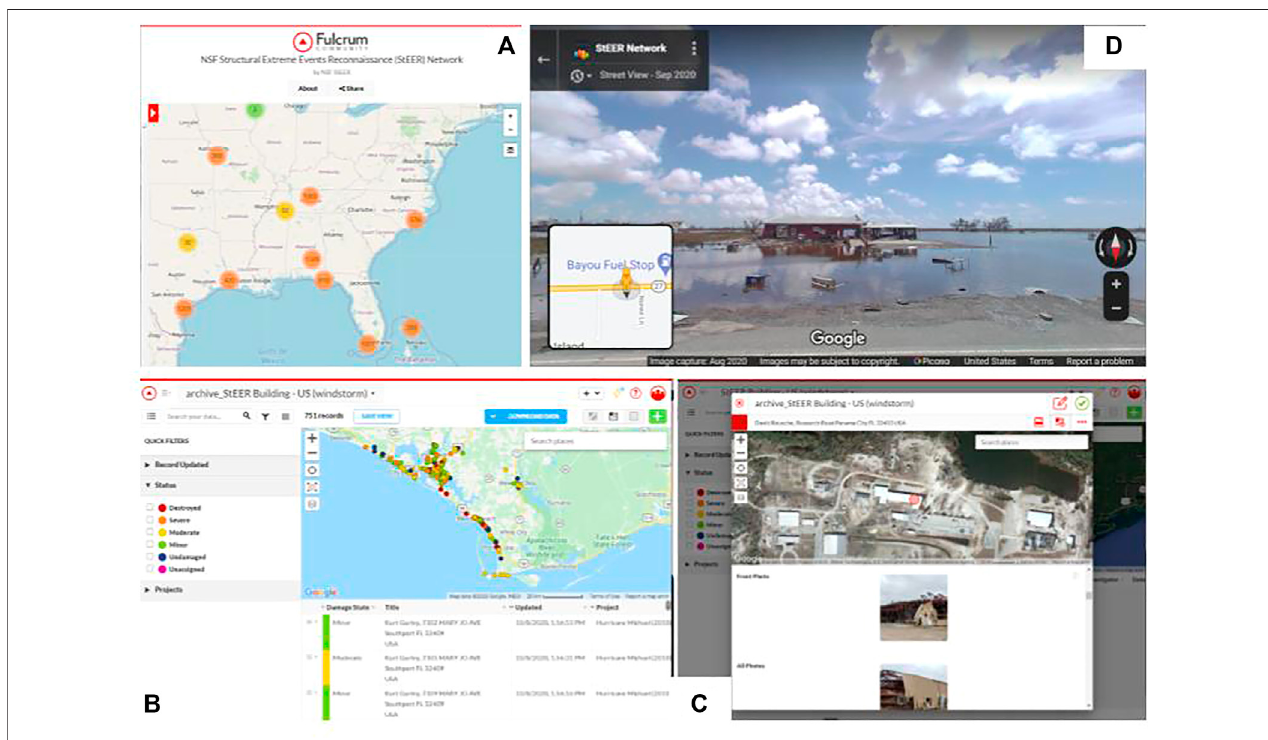
FIGURE 4 | Open platforms for sharing StEER fi eld data: ( A ) Fulcrum Community public map viewer for app-based structural assessments, ( B ) backend Fulcrum dashboard for querying and fi ltering app-based structural assessments with ability to click any record for ( C ) pop-up with all fi elds, metadata and collected media (example from Hurricane Michael); ( D ) example of StEER street-level panoramas posted to Google Maps Streetview platform (example from Hurricane Laura).